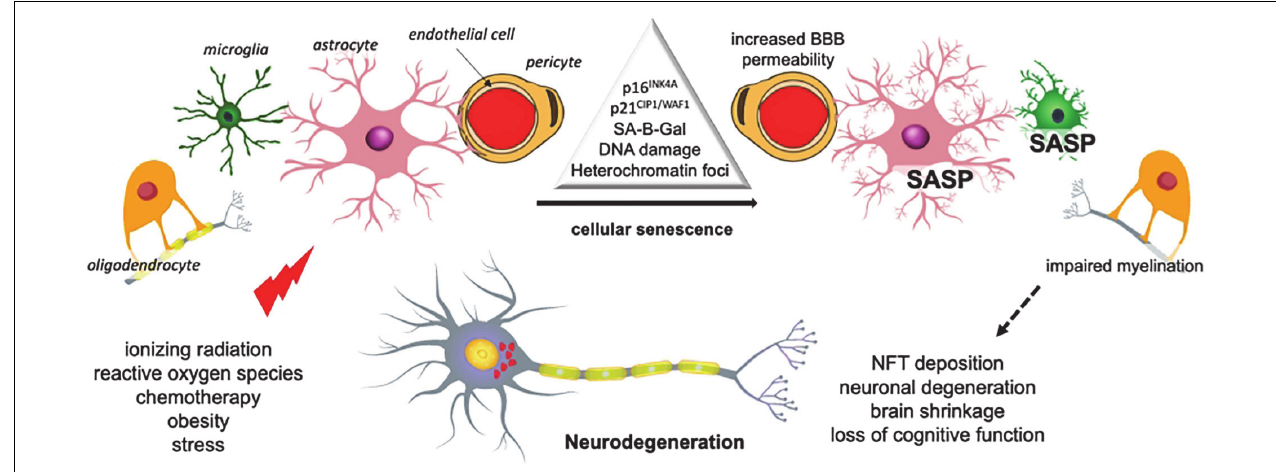
FIGURE 1 | Senescence-mediated neurodegeneration. Cellular senescence can be induced by several stimuli in the different brain cells. Senescence of microglia and astrocytes results in inflammation and the loss of trophic support. Oligodendrocyte senescence reduces myelin, which affects transmission and the BBB may be compromised by endothelial cells senescence. These changes have an impact on the integrity and viability of neurons and ultimately brain function [based on Chinta et al. (2015)]. SASP, senescence-associated secretory